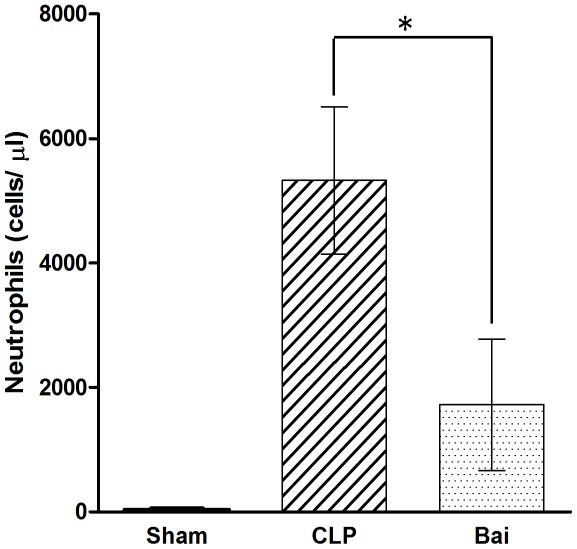
The number of neutrophils in peritoneum in septic mice after administration of baicalin.Baicalin reduced the number of neutrophils in peritoneum. Peritoneal lavage fluid were harvested 24 h after CLP. Bai, baicalin group; CLP, CLP group. Data analyses with one-way ANOVA and Newman-Keuls. * P<0.05.